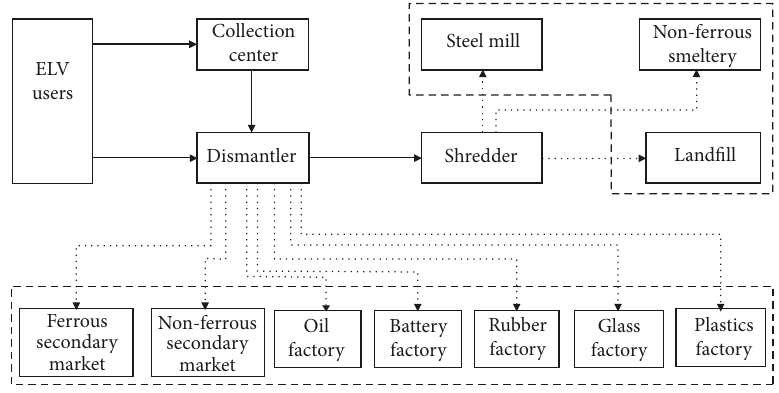
Figure 1: Structure of the ELV recovery